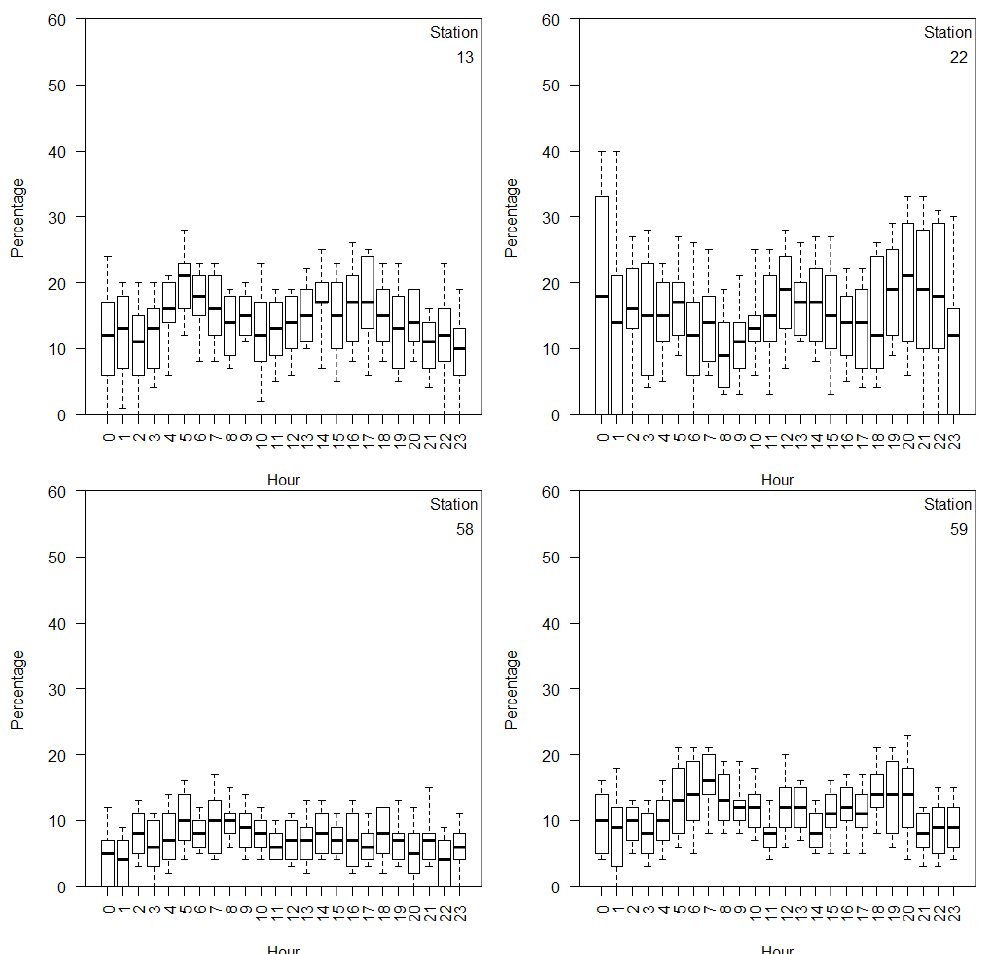
Figure 5: Percentage of overloaded category 9 vehicles in the following hours of the day for particular HS-WIM